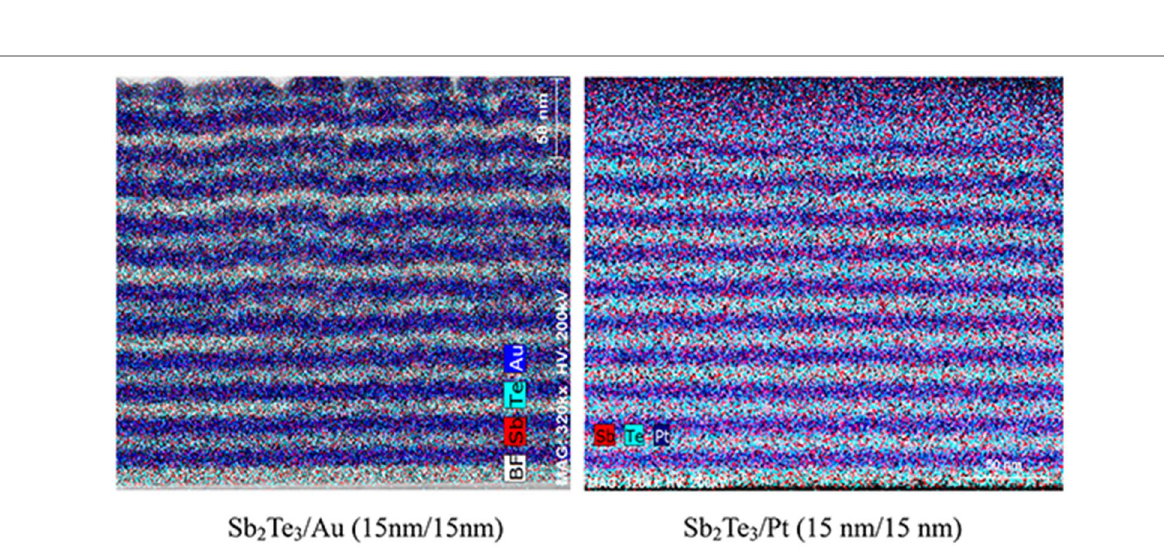
Fig. 2 EDS images of Sb 2 Te 3 /(Au, Pt) thermoelectric multilayer thin